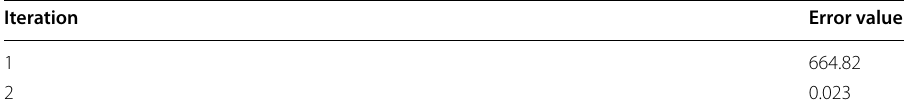
Table 14 Iteration vs error (AirBnB dataset) Iteration